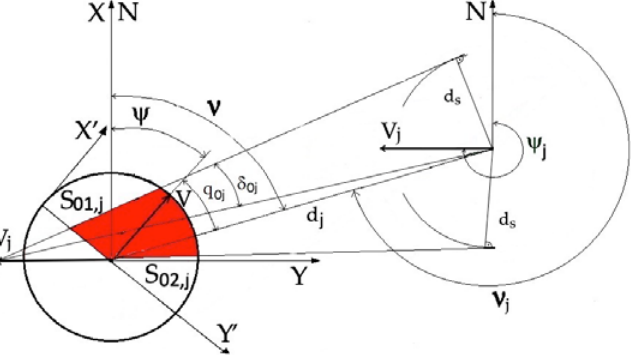
Figure 3. Sets of acceptable tactics S 01,j and S 02,j for the considered ship to keep a safe passing distance d s from the encountered ship j.